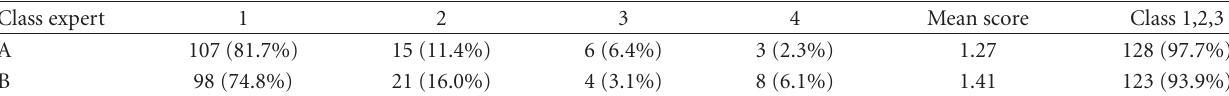
Table 1: Registration results.